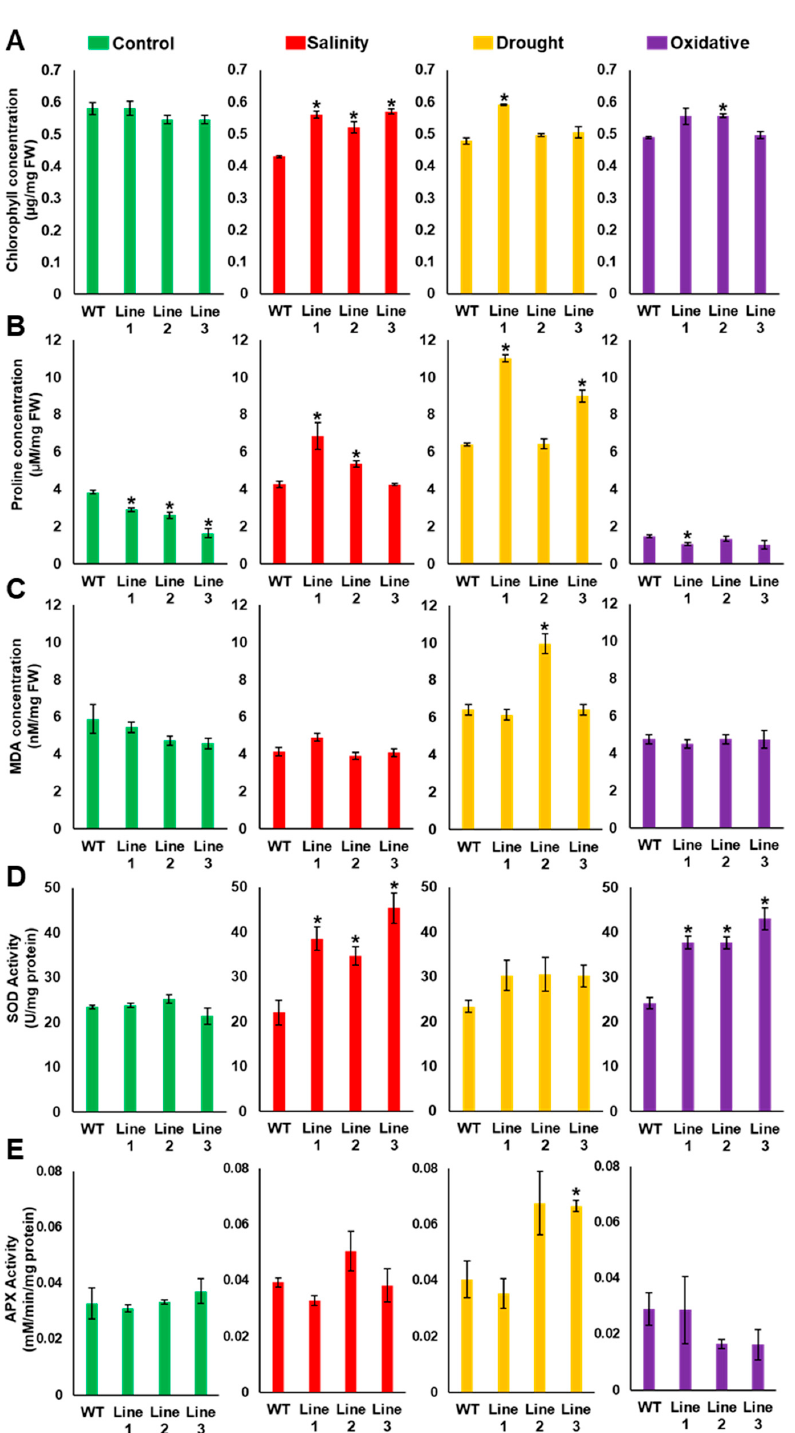
Figure 7. The e ff ect of PdMT2A on chlorophyll, proline and antioxidant enzymes. The e ff ect of drought, salinity and oxidative stress on the chlorophyll content ( A ), proline concentration ( B ), malondialdehyde (MDA) concentration ( C ), superoxide dismutase (SOD) activity ( D ) and ascorbate peroxidase (APX) activity ( E ) of PdMT2A transgenic and WT Arabidopsis plants. The bars represent the mean chlorophyll, proline or MDA concentration and the SOD or APX activity ( ± SE, n = 3), while the asterisks indicate a significant di ff erence from the WT plants ( p < 0.05). 2.5. The Soil-Grown Transgenic Arabidopsis Lines Displayed Improved Stress Tolerance